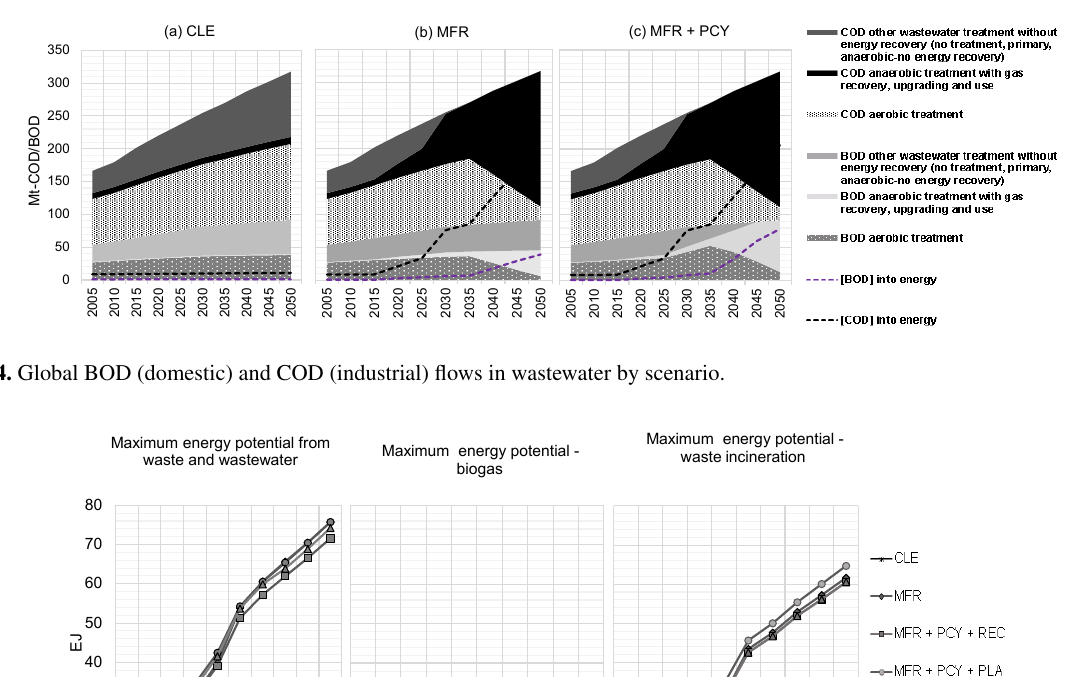
methane formed remains in the water as dissolved methane, which diminishes even further the potential for biogas gener- ation (Liu et al., 2014) – a situation which explains the lower share of energy recovered from